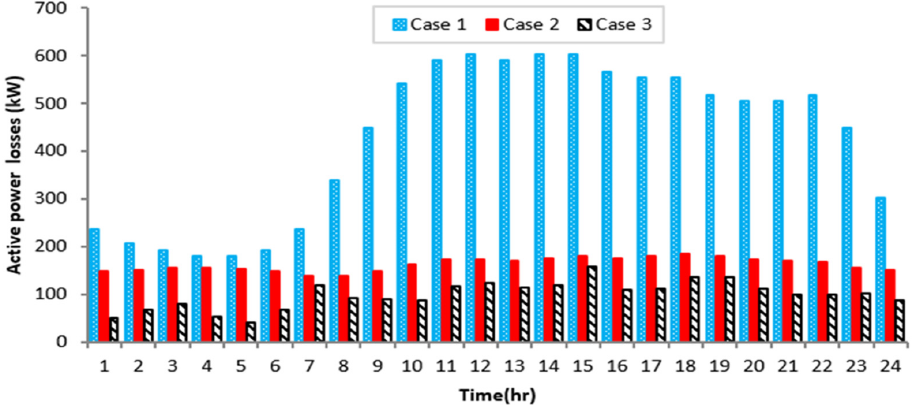
Figure 23. Active power losses for different cases studied at each hour for the second MG.